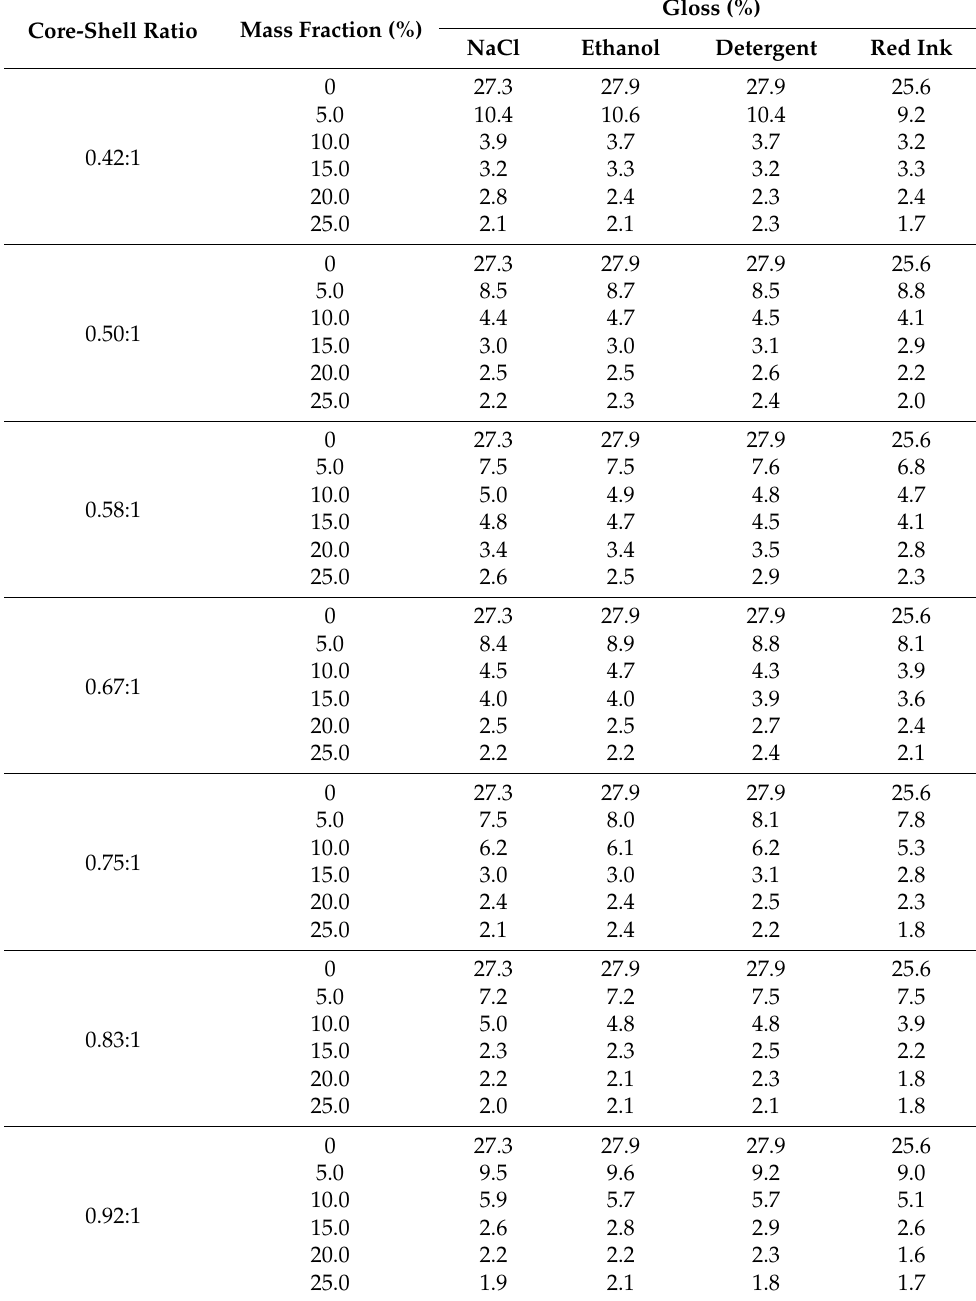
Table 8. Effect of microcapsule concentration and core-shell ratio on the gloss of painted surfaces after exposure to different